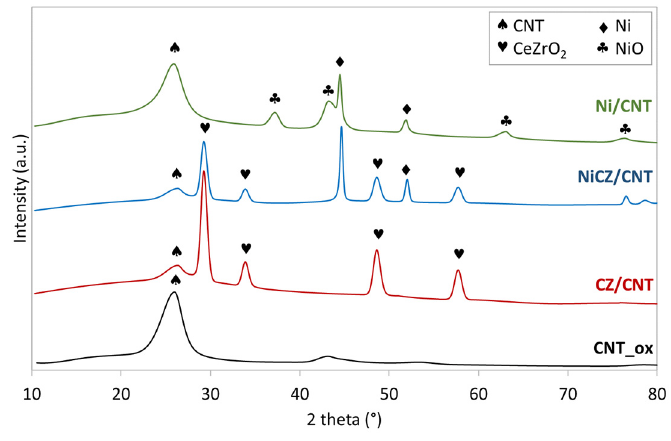
Figure 1. XRD patterns of CNT_ox, CZ / CNT, NiCZ / CNT and Ni / CNT.